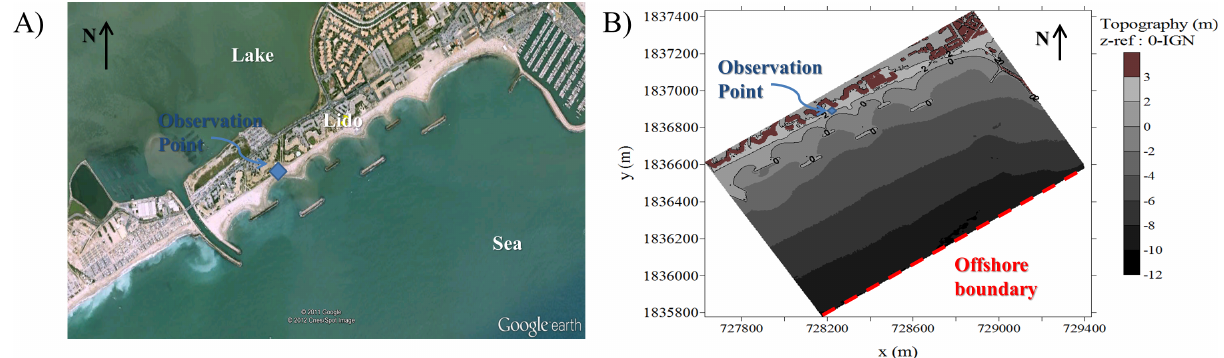
Fig. 2. (A) Location of the study site and observation point where the calculations are carried out; (B) SWAN 2-D domain model of the study site.